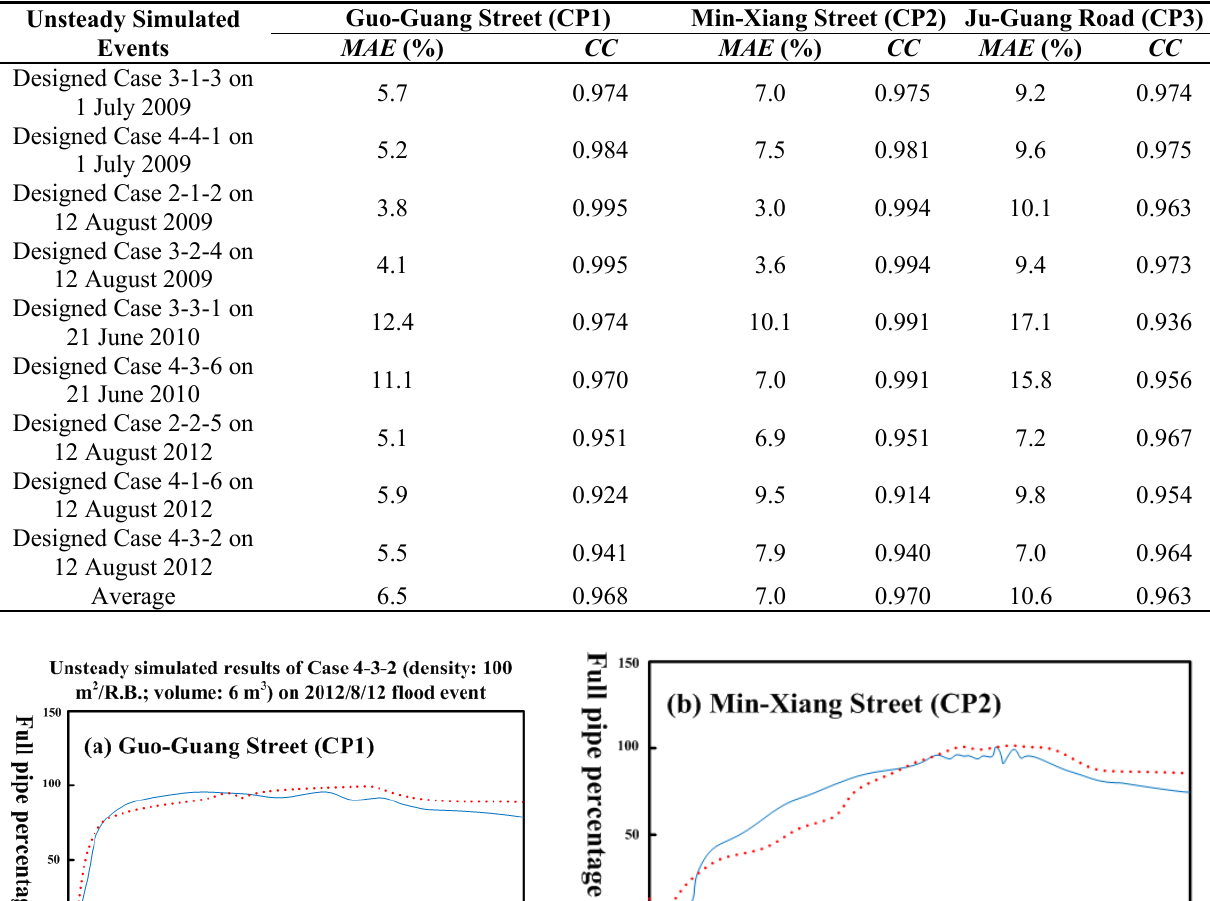
Table 5. Unsteady continuous simulated results for validation of BPNN-based